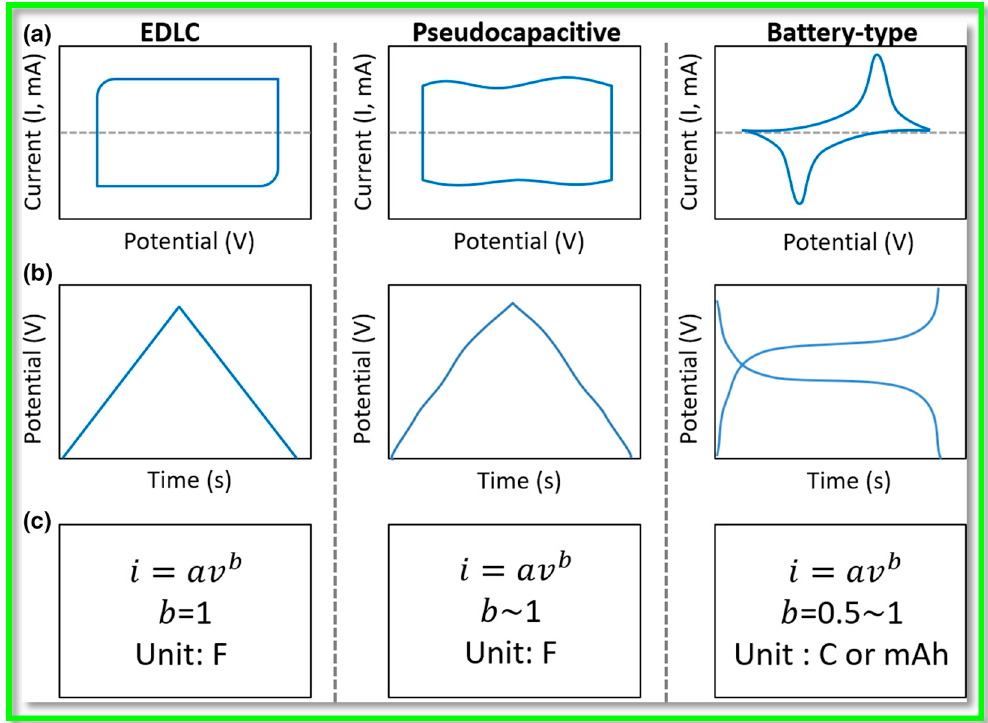
Figure 4. The electrochemical signatures for various type of charge storage mechanisms as EDLC, pseudocapacitive, and battery-type: ( a ) CVs, and ( b ) GCDs, along with their ( c ) quantitative kinetics analysis through the calculation of b in formula i(V) = avb. Reprinted with permission from [49], Copyright 2019, Wiley-VCH.